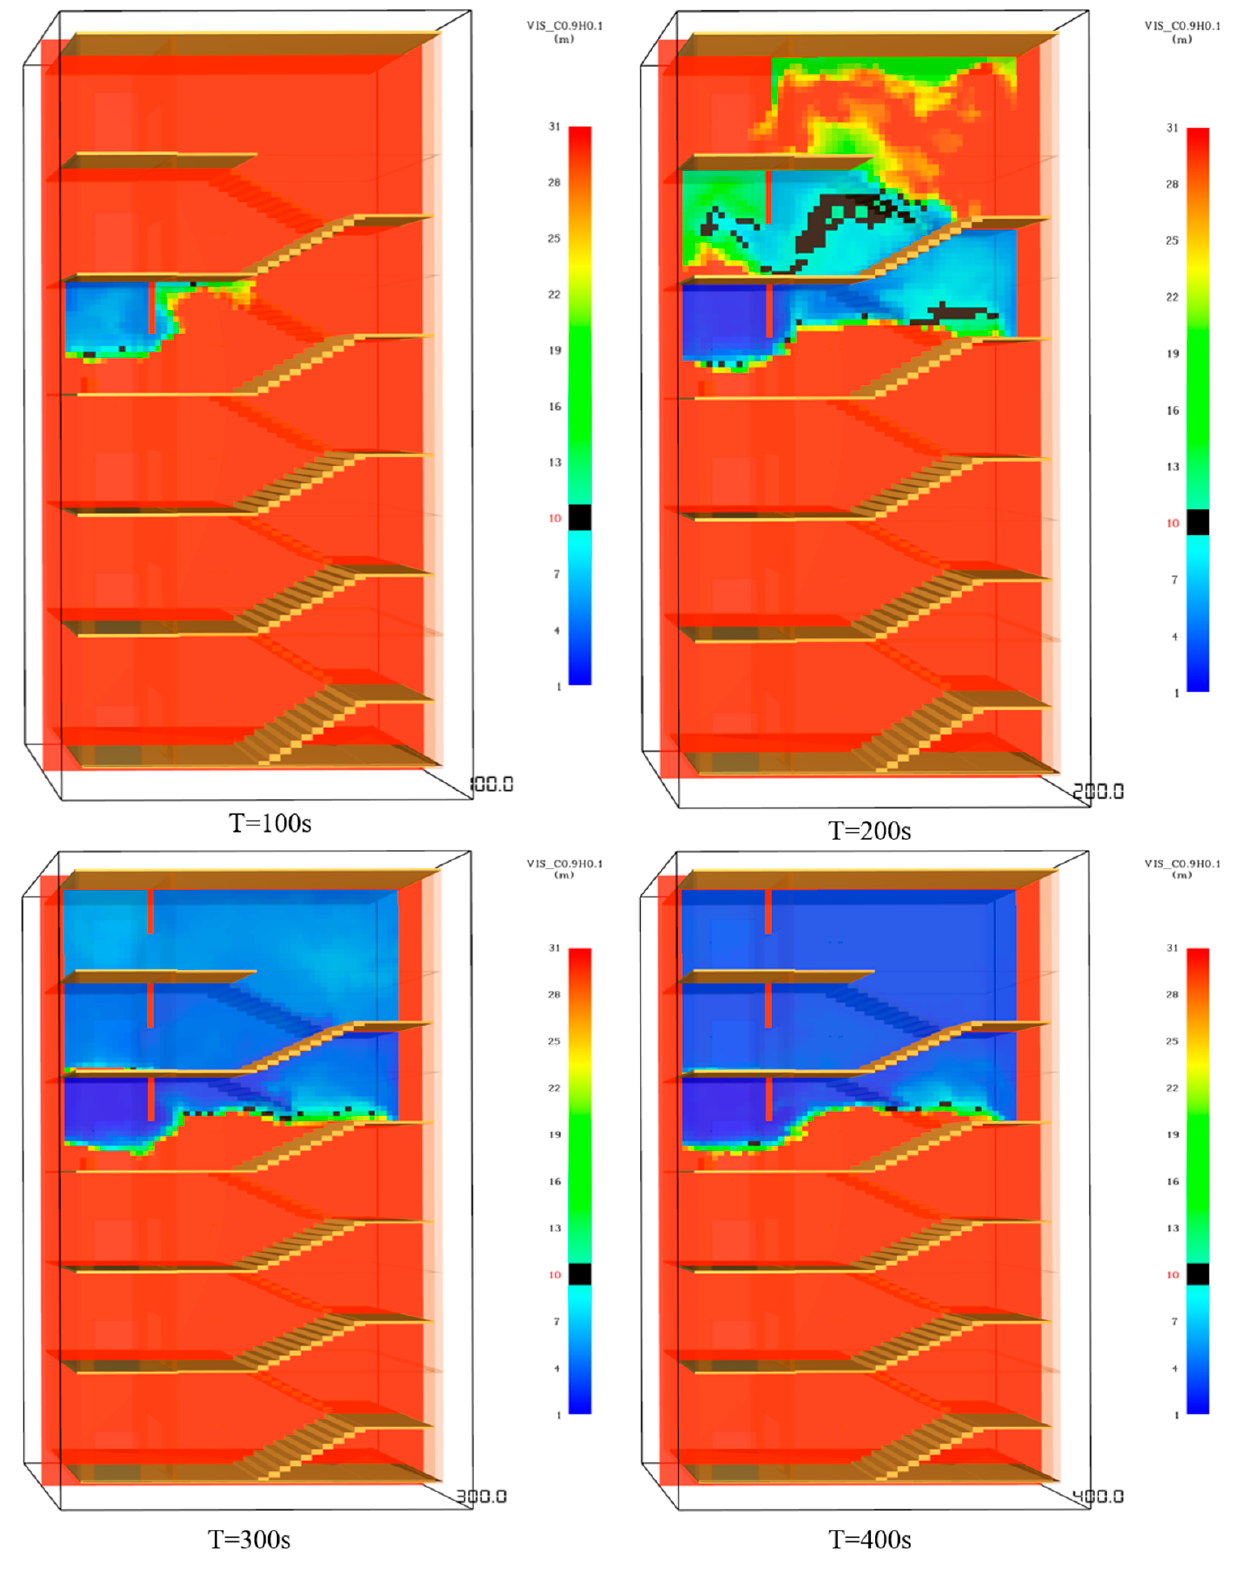
Figure 9. Visibility changes of staircase front room and staircase.